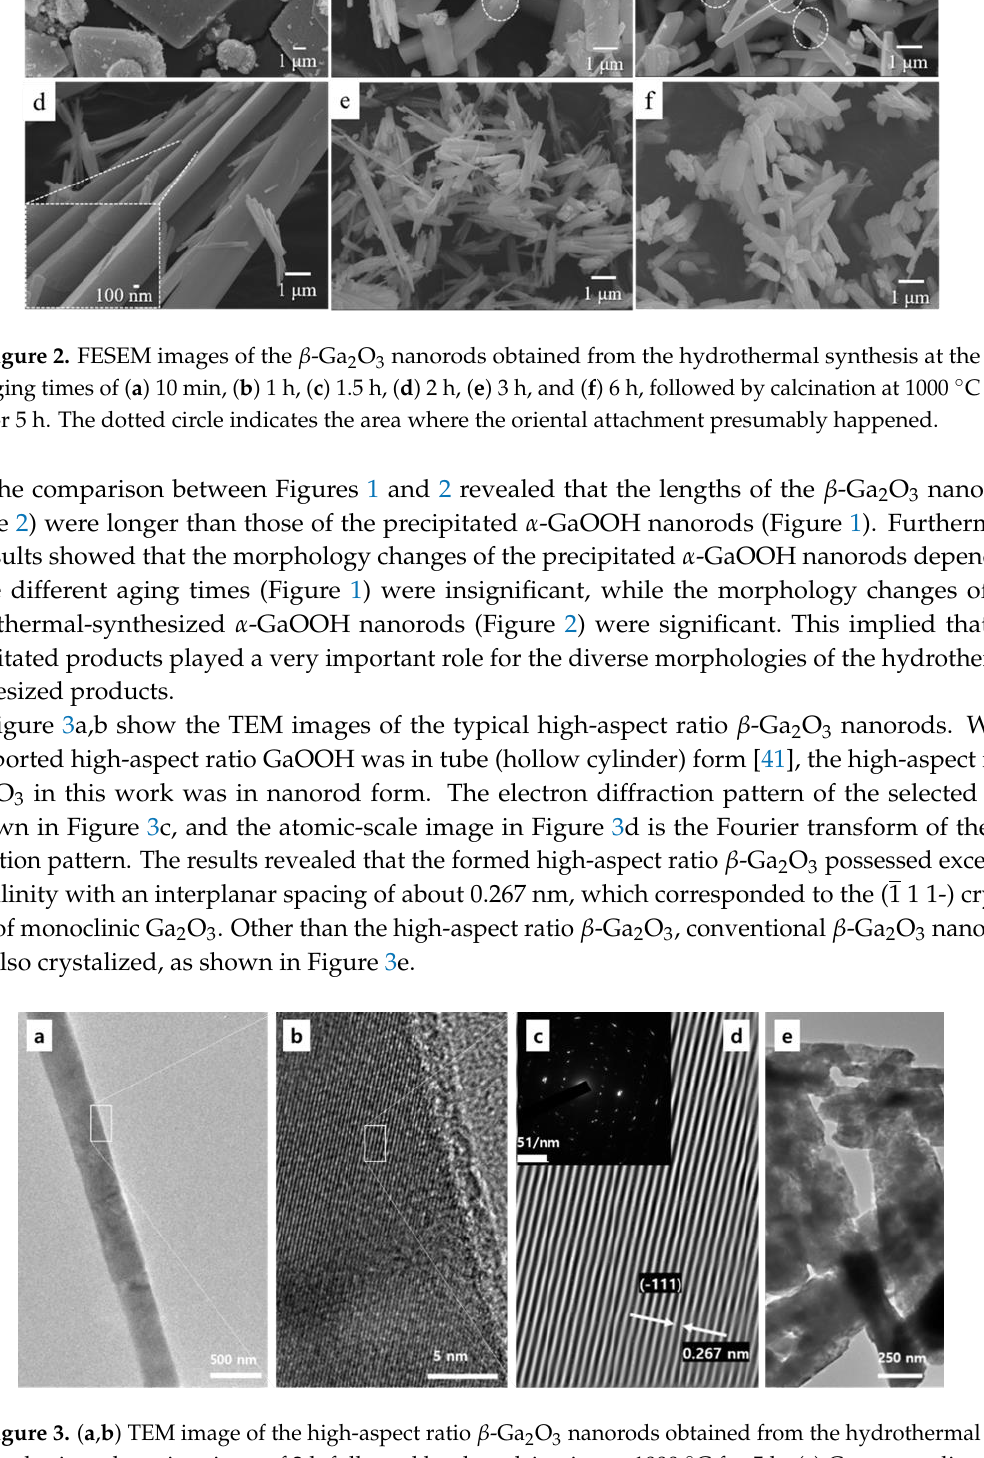
Figure 3. ( a , b ) TEM image of the high-aspect ratio β -Ga 2 O 3 nanorods obtained from the